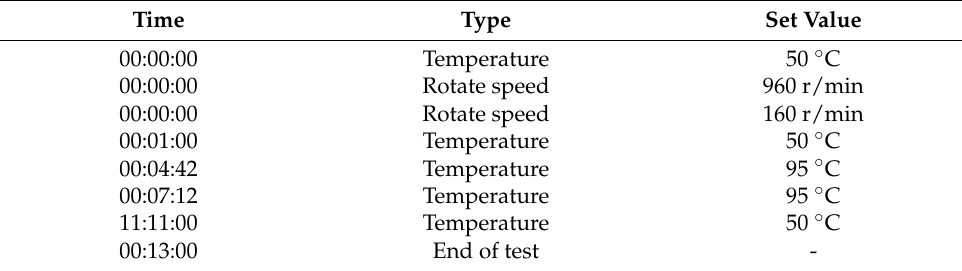
Table 1. Rapid viscosity analyzer (RVA) program